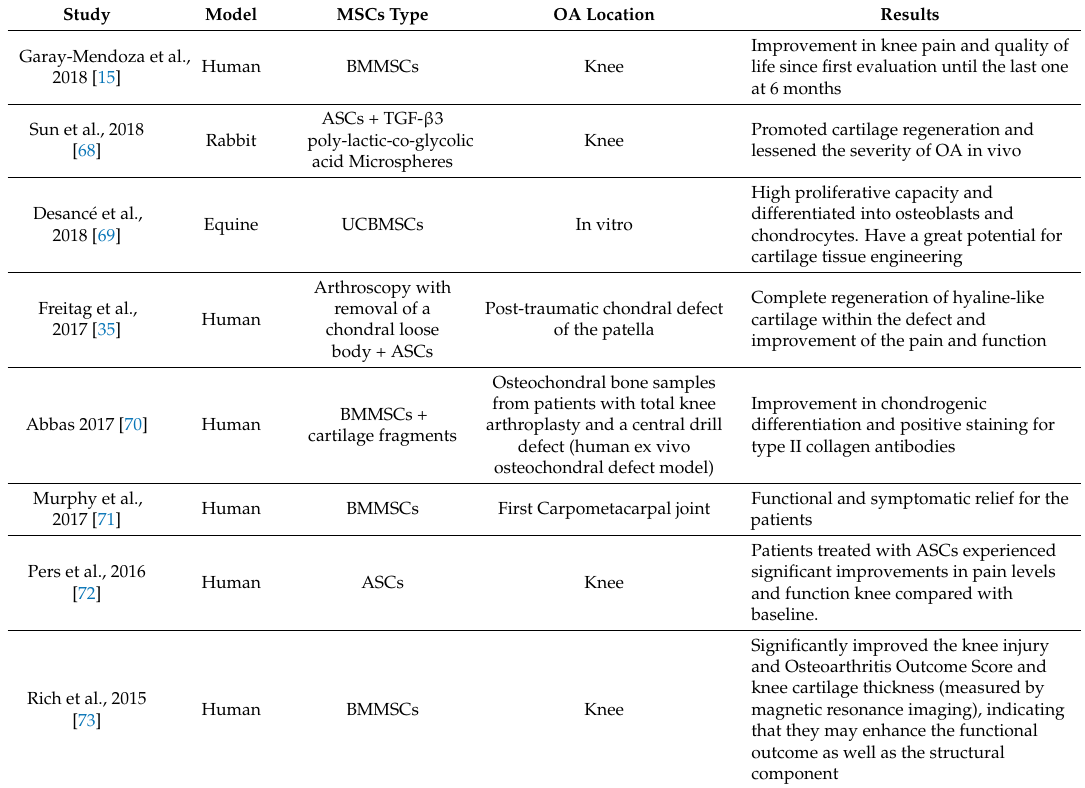
Table 1. Research on osteoarthritis with MSC-based